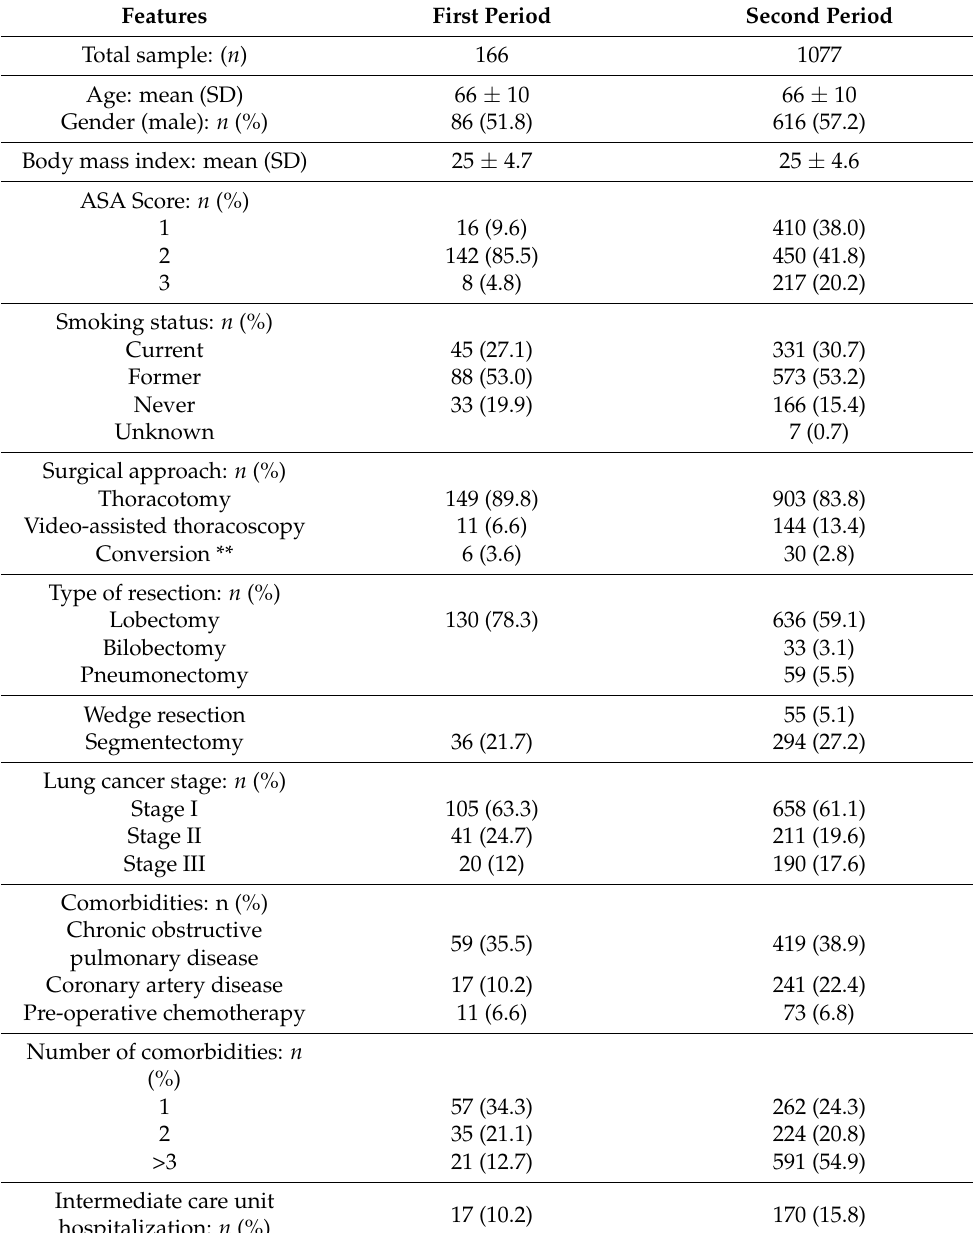
Table 2. Population